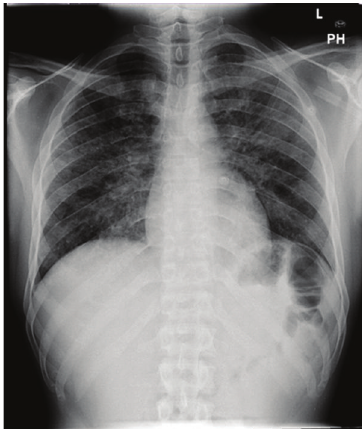
Figure 1: Upright posterior-anterior projection chest X-ray demon- strating diffuse reticular-nodular opacities in both lungs.